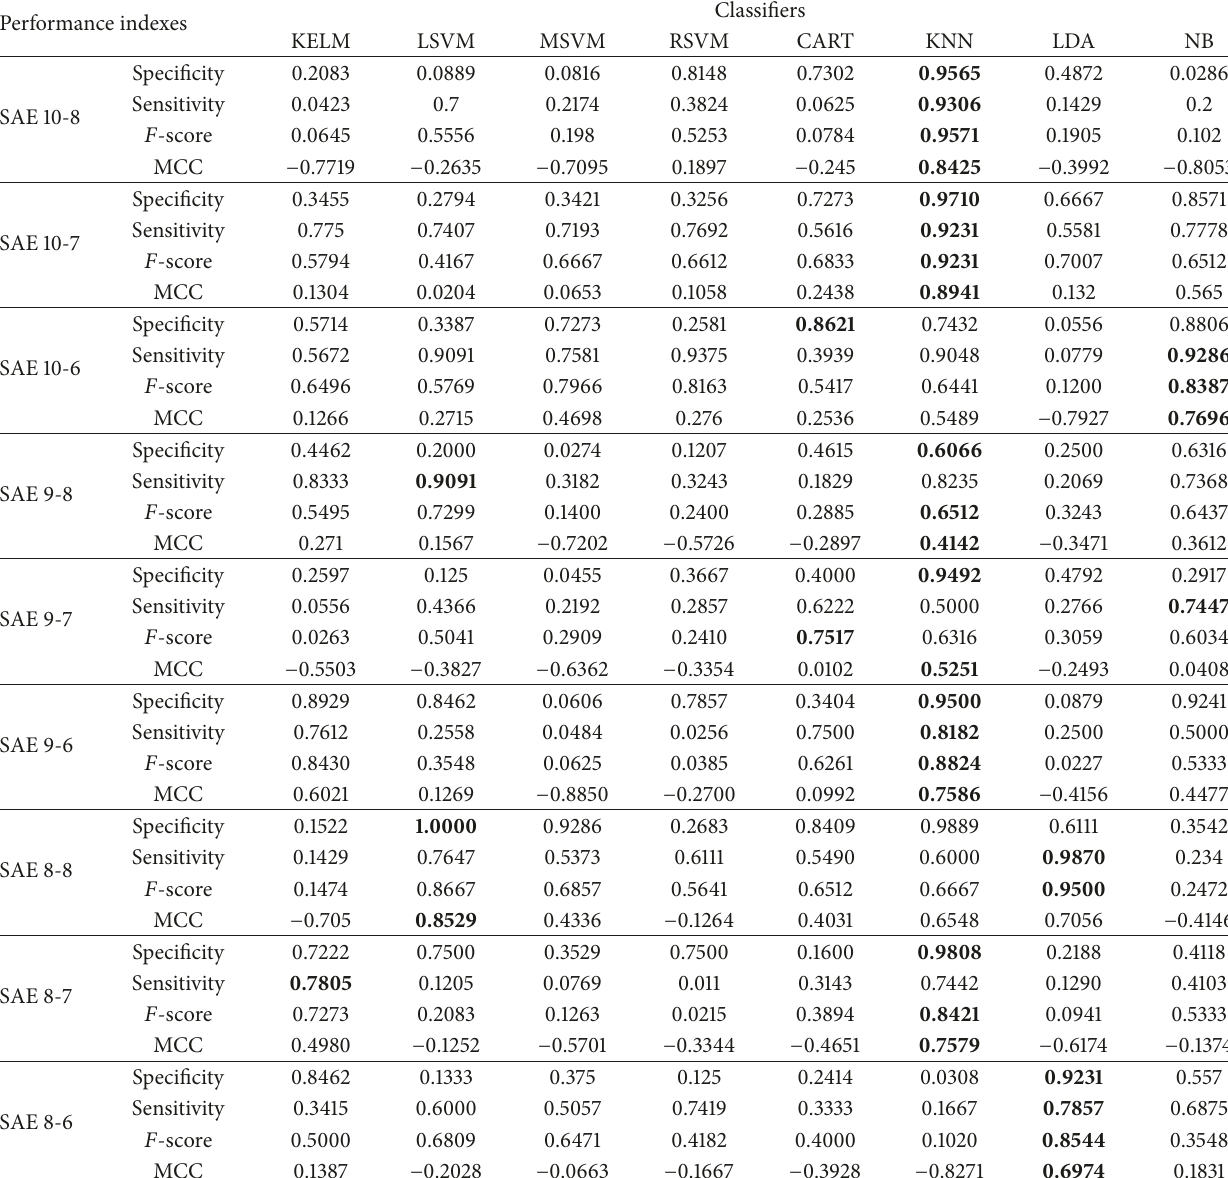
Table 5: Performance indexes of comparative classifiers with SAE on Oxford Dataset (average of 10 runs) .